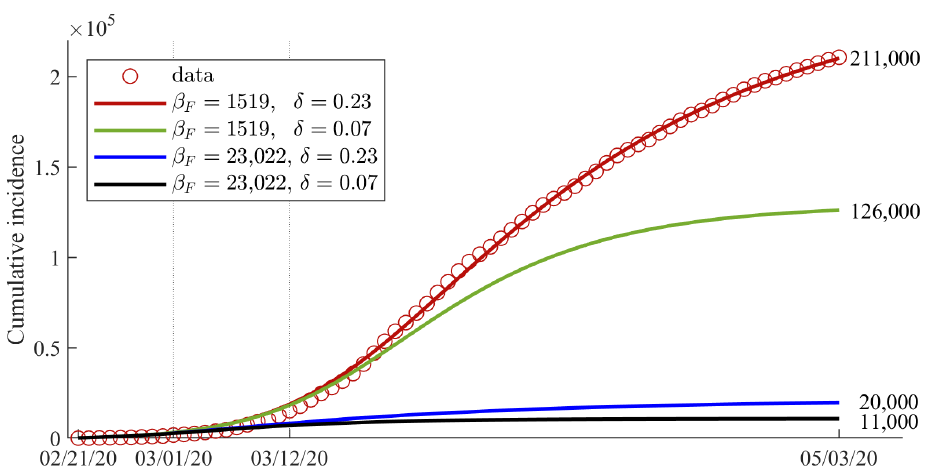
Figure 7. Expected number of cumulative confirmed cases if individuals in Italy had changed their behaviors faster and more